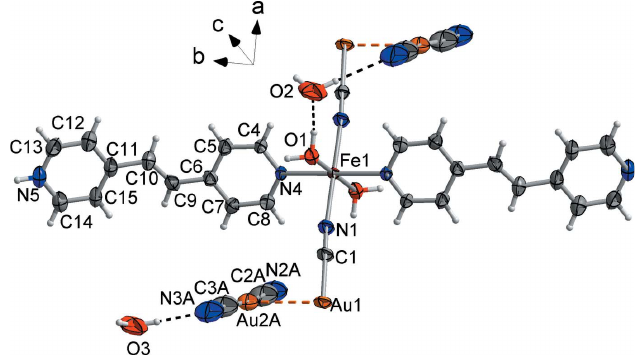
Figure 1 A fragment of the crystal structure of the title compound showing the atom-labelling scheme. Displacement ellipsoids are drawn at the 50% probability level. The guest bpe molecule and disorder of the [Au(CN) 2 ] (cid:4) counter-ions are not shown for clarity. Symmetry-generated atoms are not